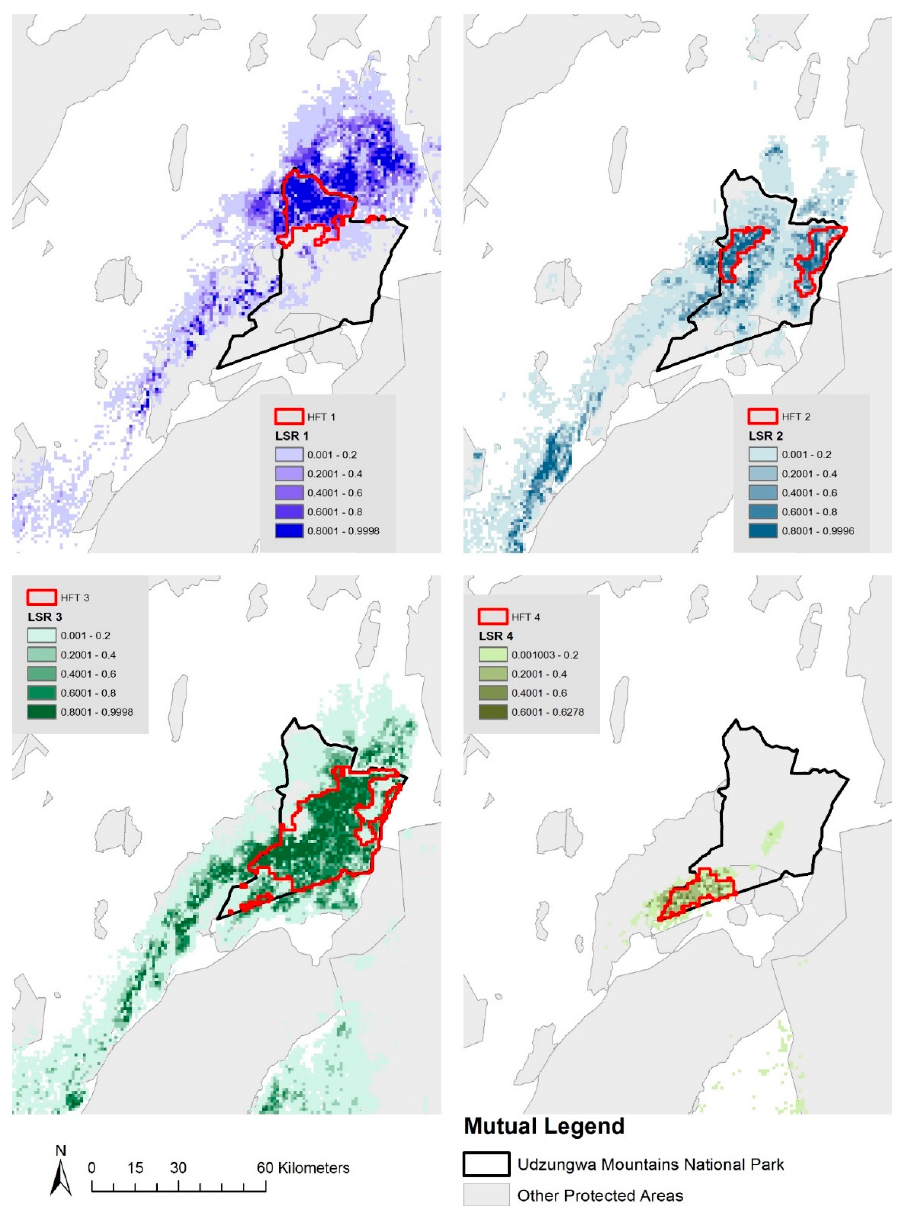
Figure 7. Boundaries of the 4 Habitat Functional Types (HFT) delineated in red and their associated maps of landscape similarities where each pixel is assigned a value where 1 = high and 0 = no similarity with the area. The similarity maps are used to derive the Landscape Similarity Ratio (LSR) for each HFT.